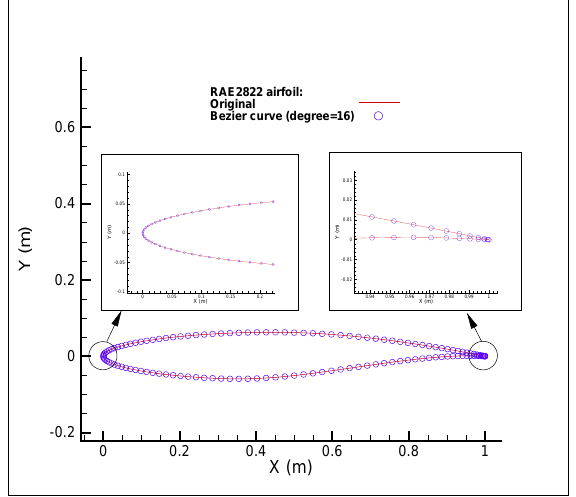
Figure 6. Comparison of original RAE2822 airfoil and reconstructed RAE2822 airfoil using a Bezier curve of degree 16.